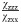
A) Histograms of χzzzχzxx values obtained for gels with varying collagen type III concentration.The bars represent experimentally acquired data. The red line is the bimodal Gaussian fit to the data. B) Standard curve for collagen type III concentration. The known concentration of collagen concentration is plotted against the ratio of the area under the collagen type III peak ~0.8 to the total area under the Gaussian fit.